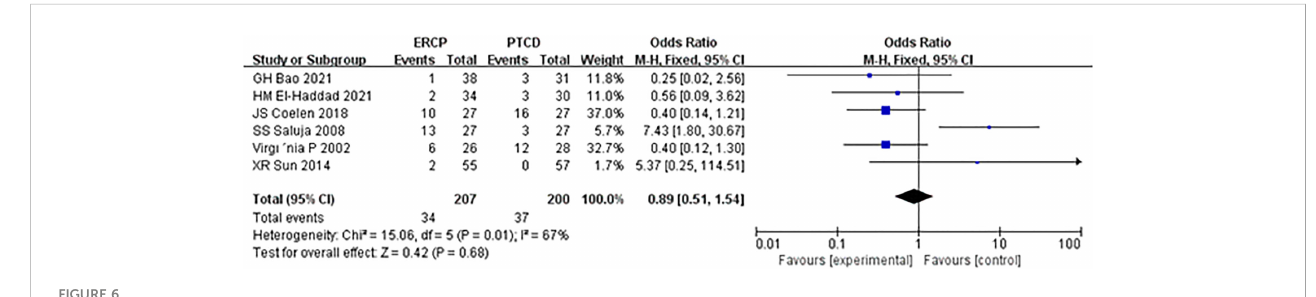
FIGURE 6 Forest plot comparing the incidence of procedure-related